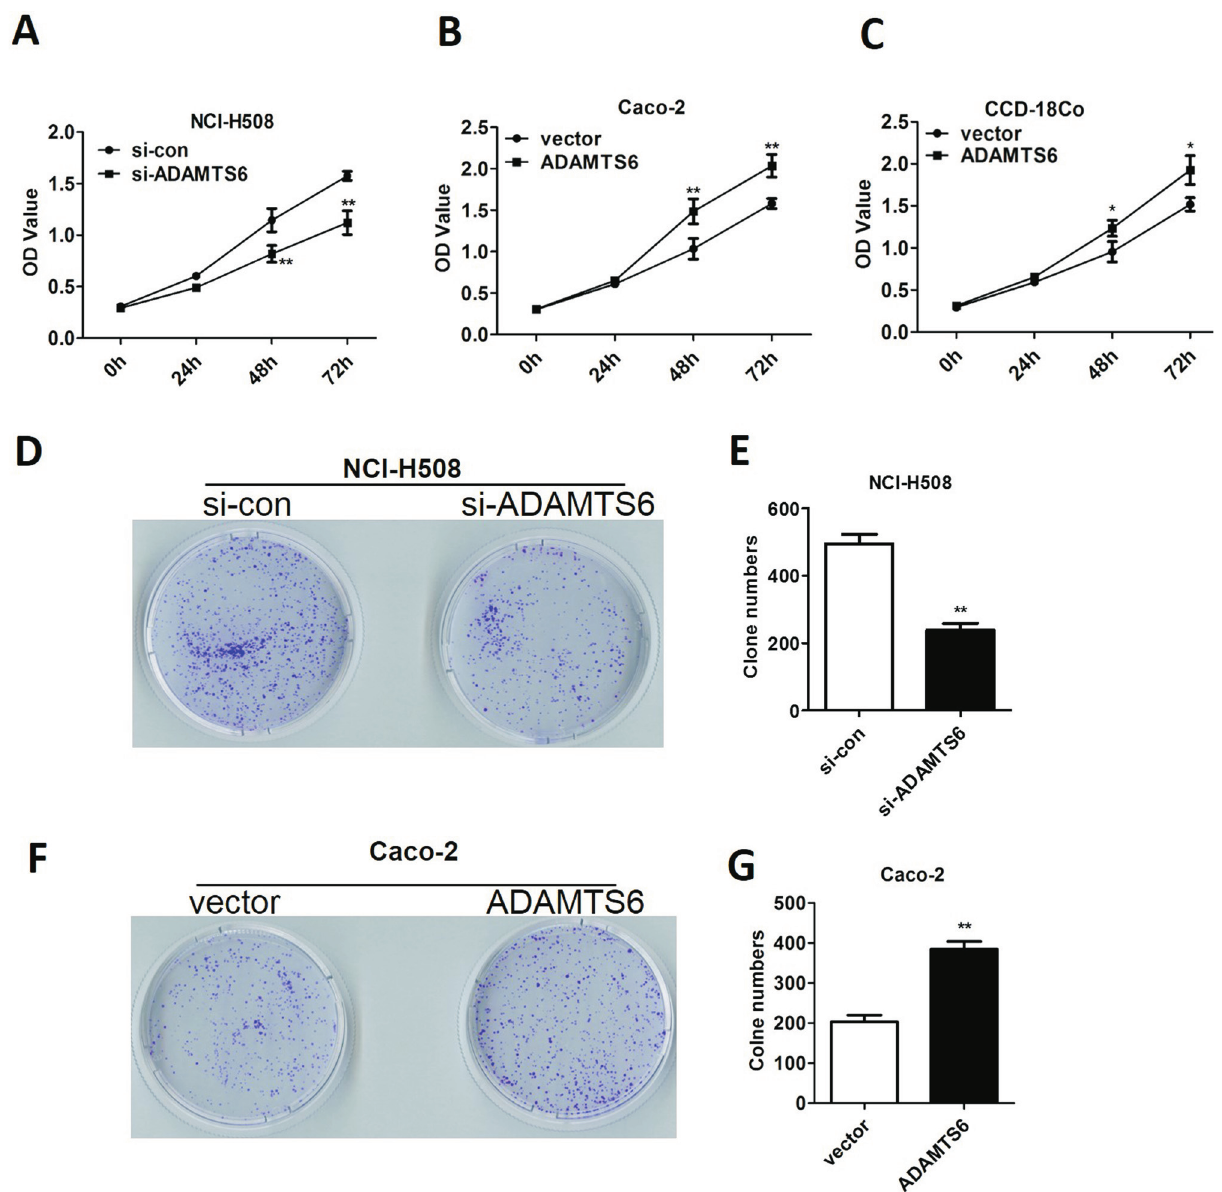
Figure3 -TheeffectofADAMTS6ontheproliferationofNCI-H508,Caco-2andCCD-18Cocells.(A)CCK8analysisindicatedthatsilencingofADAMTS6 restrained cell proliferation in NCI-H508 cells. **P <0.01 compared with si-con group. (B-C) CCK8 analysis indicated that the overexpression of ADAMTS6 facilitatedcellproliferationinCaco-2cells(B)andCCD-18Cocells(C).**P<0.01comparedwithvectorgroup.(D-E)Theanalysisofcolonyformationrates in si-con and si-ADAMTS6 groups. **P <0.01 compared with si-con group. (F-G) The analysis of colony formation rates in vector and pcDNA3.1-ADAMTS6 groups. ** P <0.01 compared to vector